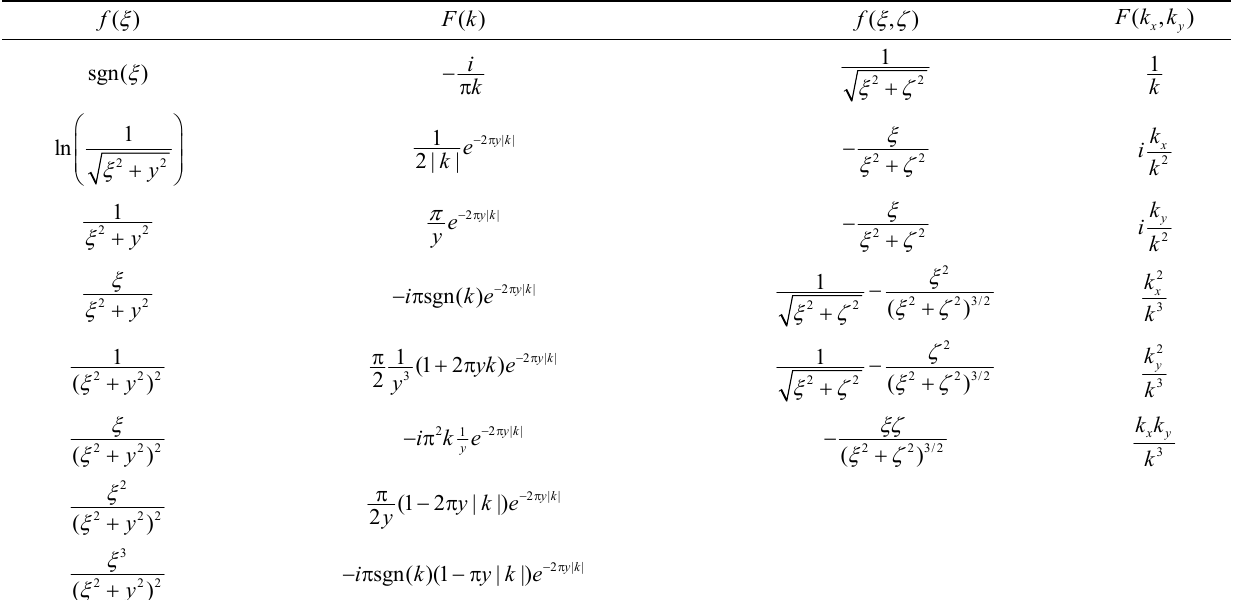
Table B1 One-dimensional and two-dimensional Fourier transform table. Note that 0  y